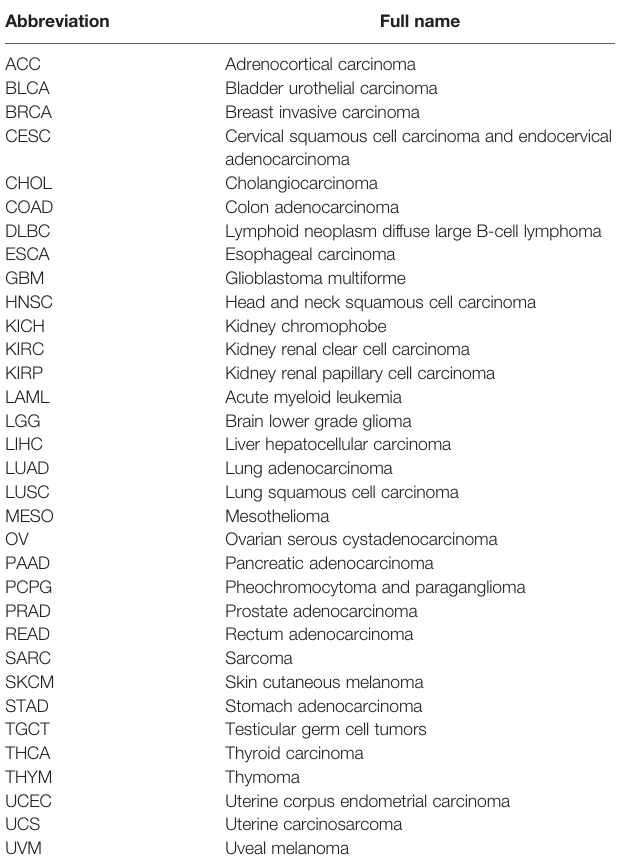
TABLE 1 | 33 types of human cancers employed in our